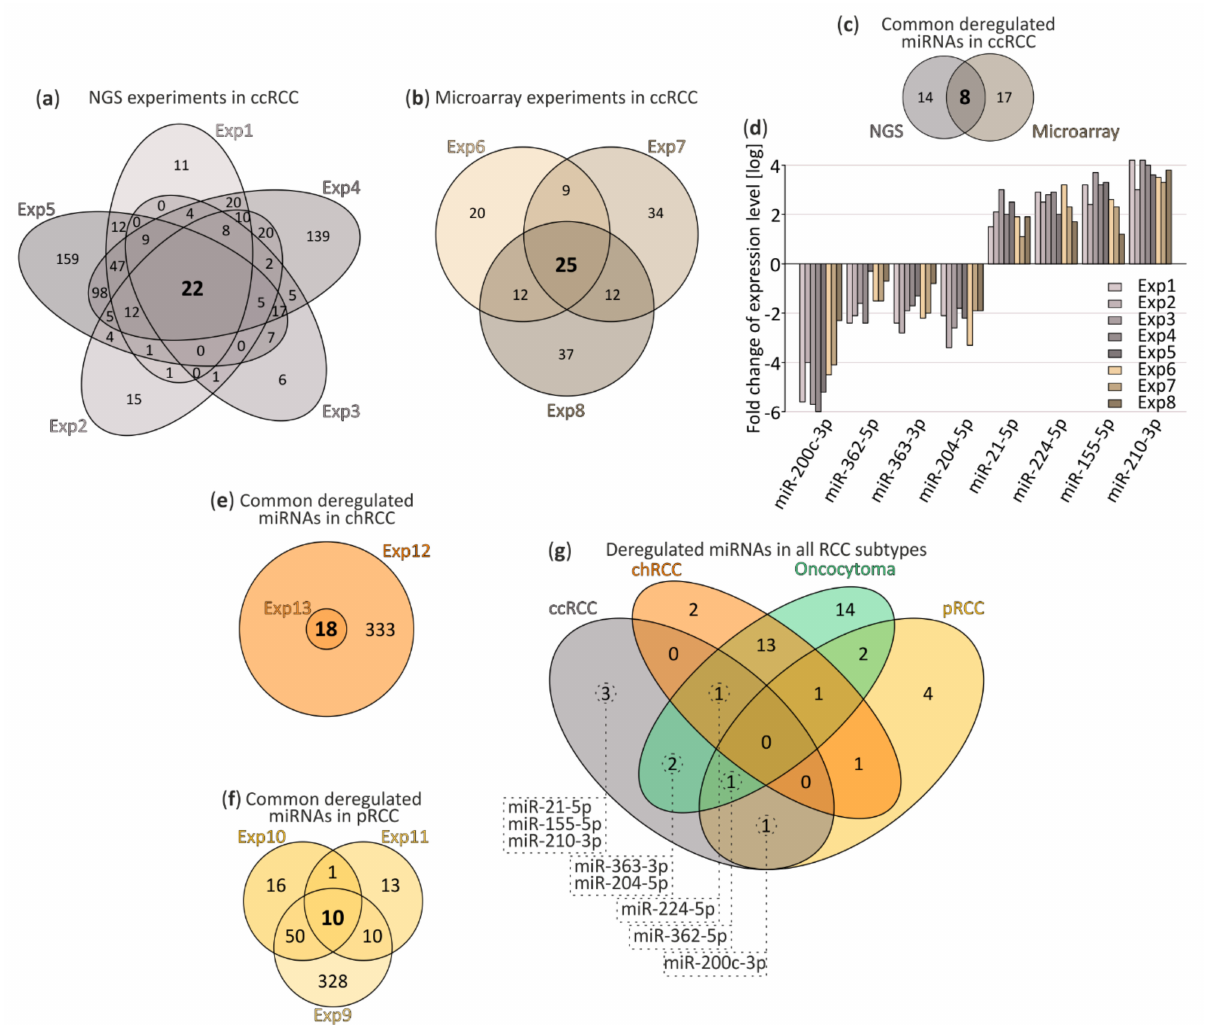
Figure 1. The meta-analysis of deregulated miRNA in renal cell carcinoma (RCC) tumor tissues. ( a , b ) Venn diagrams depicting commonly deregulated miRNAs in clear cell renal cell carcinoma (ccRCC) tumors. ( a ) small RNA-seq and ( b ) microarray experiments; ( c , d ) Comparison of commonly deregulated miRNA in chromophobe renal cell carcinoma (chRCC) ( c ) and papillary (pRCC) ( d ); ( e ) miRNA identified in both next-generation sequencing (NGS) and microarray experiments performed in ccRCC; ( f ) Comparison of eight miRNA expression levels commonly disrupted in ccRCC reported in original NGS and microarray experiments; ( g ) Comparison of commonly deregulated miRNA in ccRCC (8 miRNA), chRCC (18 miRNA), oncocytoma (34 miRNA) and pRCC (10 miRNA). ccRCC, clear renal cell carcinoma; chRCC, chromophobe